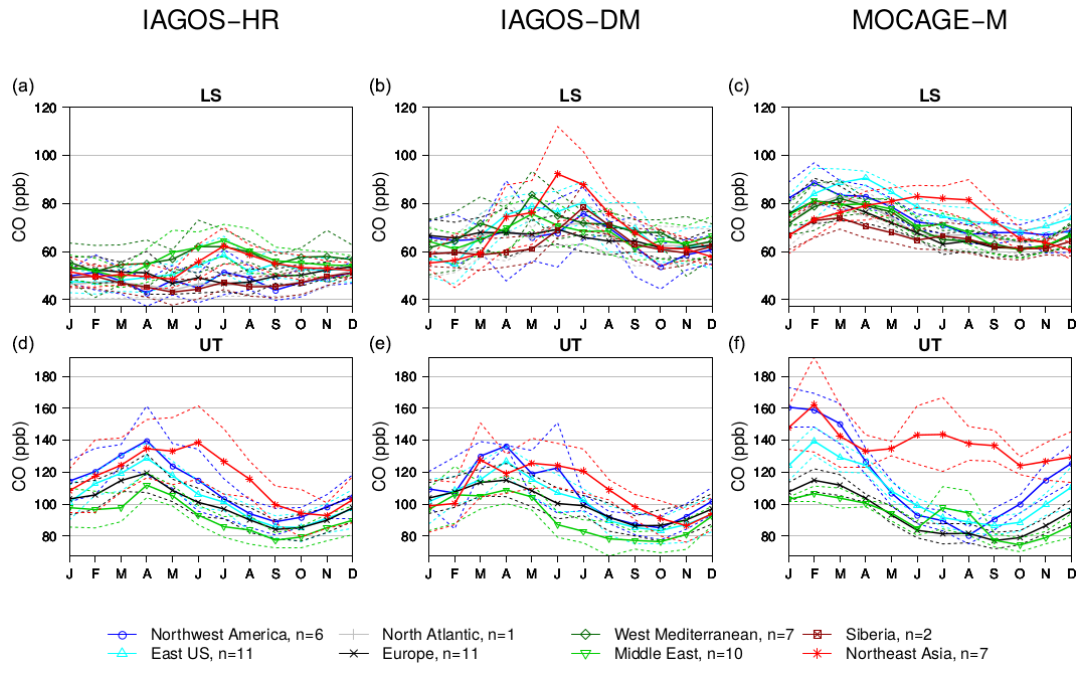
Figure 8. Same as Fig. 7 for carbon monoxide from 2002 to